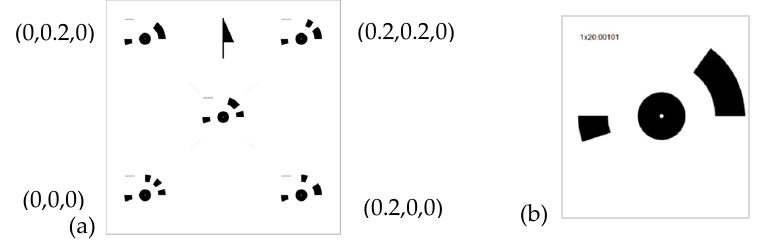
Figure 2. Orientation control board ( a ) with known local coordinates used to orient the 3D model, and ( b ) control point example that was used in the field test to control the accuracy of SfM-MVS reconstruction.